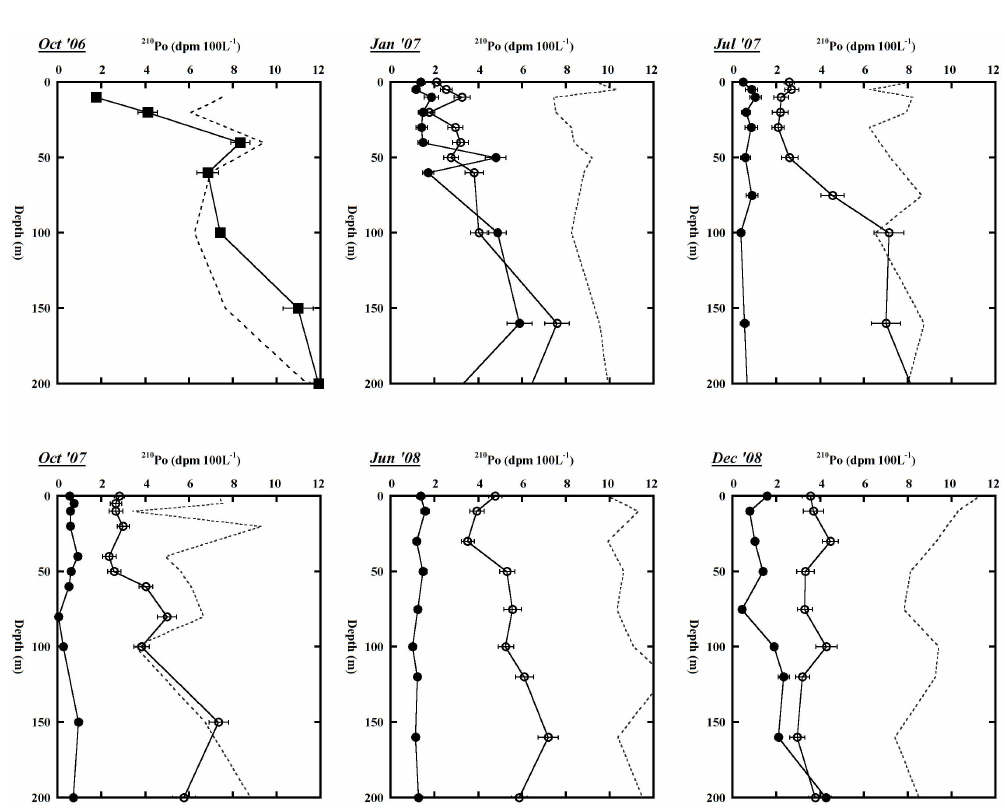
Fig. 4. Vertical distributions of dissolved (open square) and particulate (solid square) 210 Po, TSM concentration (solid circle), and total 210 Pb (thick dotted line) calculated by the sum of 210 Pb (October 2006). Error bars represent uncertainty based on propagated counting errors ( ± 1 σ